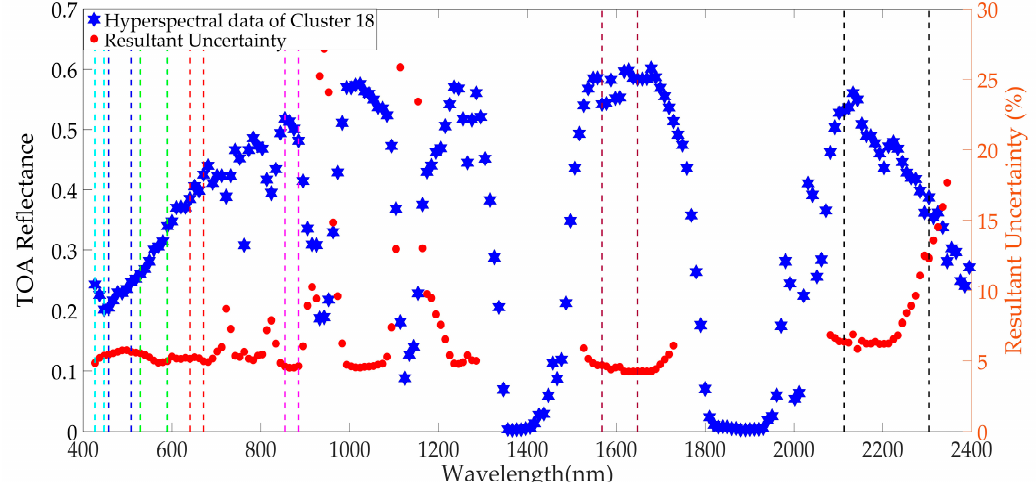
Figure A15. Estimated representative hyperspectral profile of Cluster 18 and its resultant uncertainty.